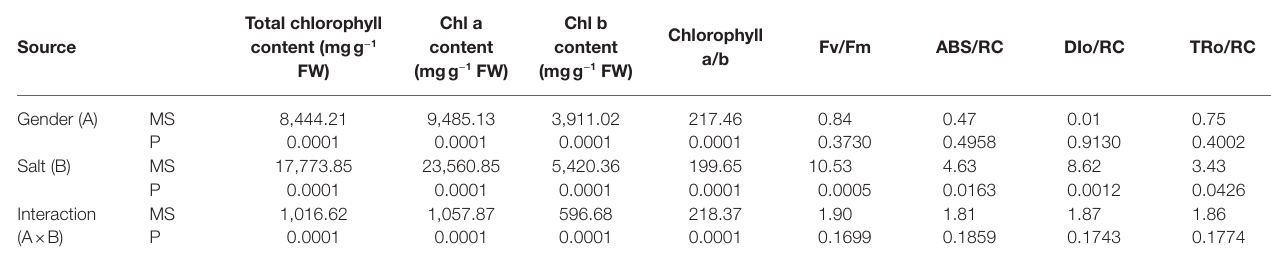
TABLE 1 | Summary of significance levels (two-way ANOVA) for the effects of gender, salt, and their interaction on the contents of photosynthetic pigments and fluorescence parameters.